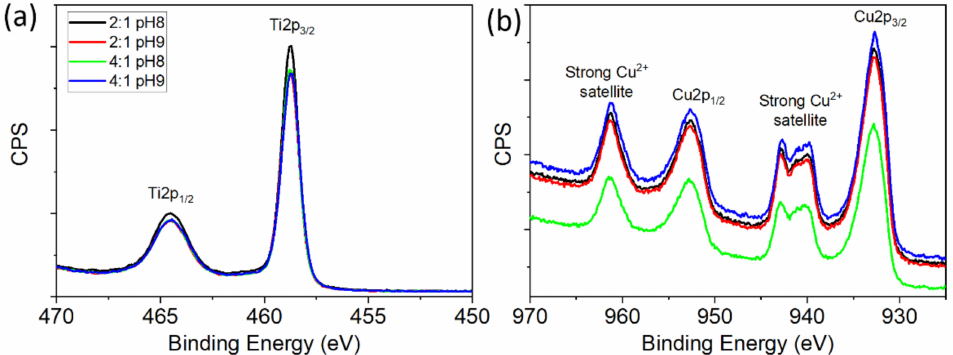
Figure 9. XPS spectra of the ( a ) Ti 2p and ( b ) Cu 2p peaks for the TiO 2 and CuO powders,